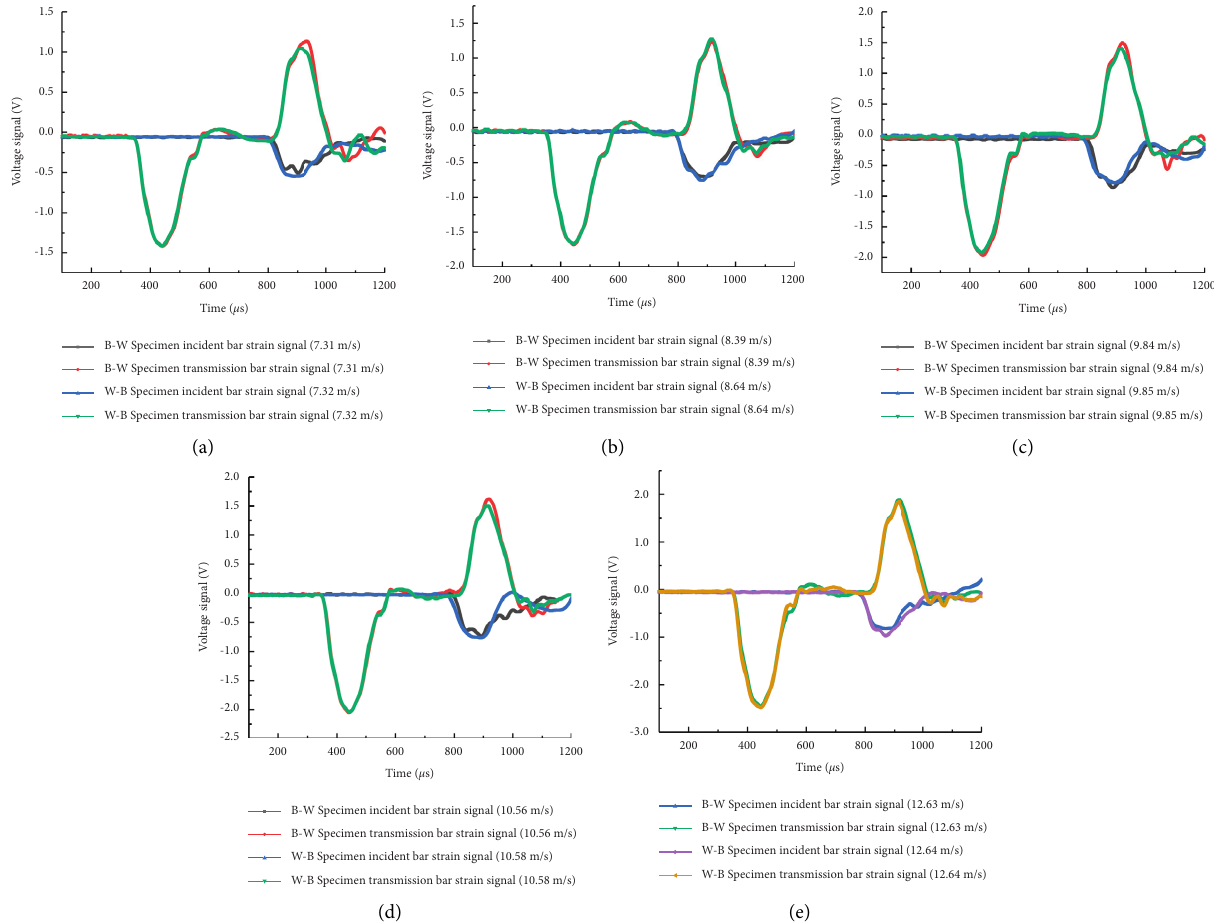
Figure 5: Waveforms of B ⟶ W and W ⟶ B composite rock samples at different impact velocities. (a) 7.2m/s. (b) 8.6 m/s. (c) 9.8m/s. (d) 10.4m/s. (e)